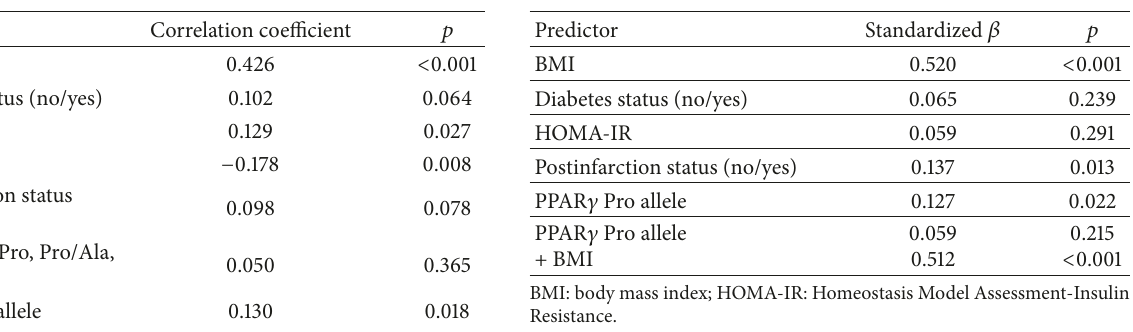
Table 7: Correlation between serum fetuin-A and investigated parameters (𝑛 = 327) .